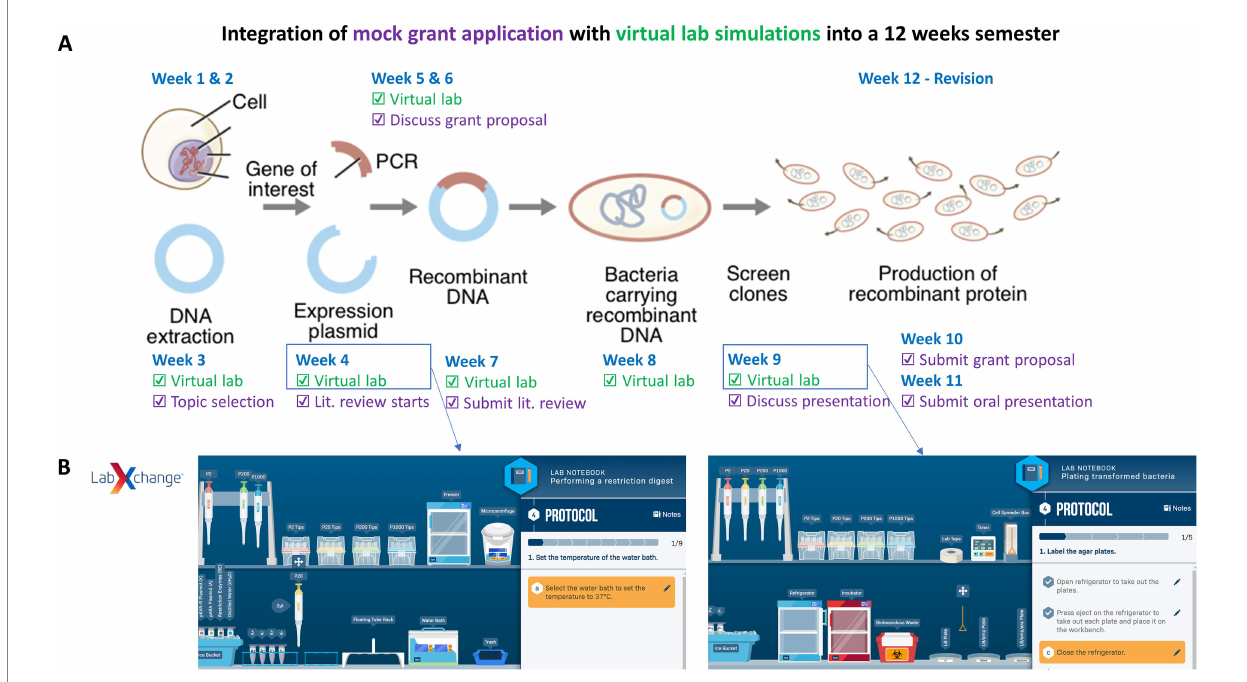
FIGURE 2 (A) Overview of the major concepts in the Recombinant DNA Technology unit and the integration of mock grant applications with virtual lab simulations. (B) Screenshot of two sample virtual lab simulations from Week 4 and 9 hosted on